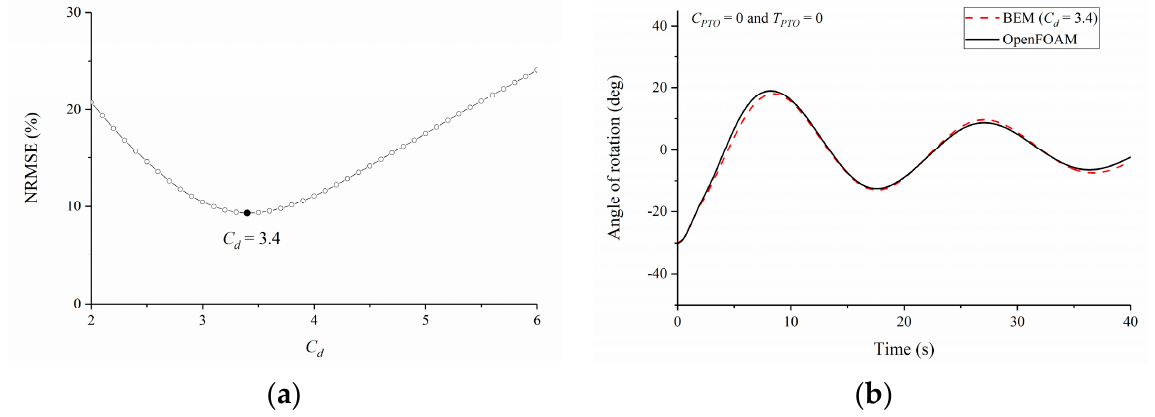
For a 40 s simulation time of a 30 deg. initial angle free decay response, the compu-